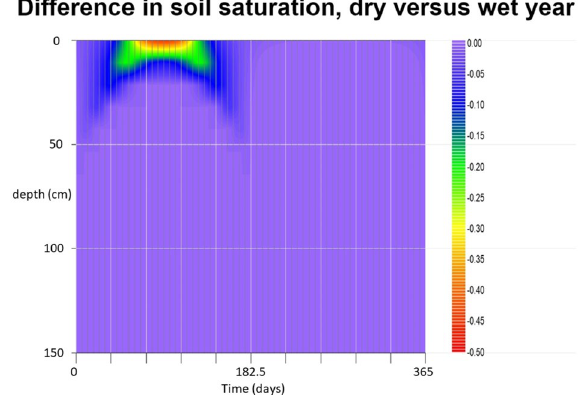
Fig. 8 Difference in soil moisture content as fraction ((soil moisture wet year—soil moisture dry year)/(soil moisture wet year)) in a dry versus a wet year during a period of 365 days. Time (in days) on the x-axis, the soil depth (in cm) on the y-axis